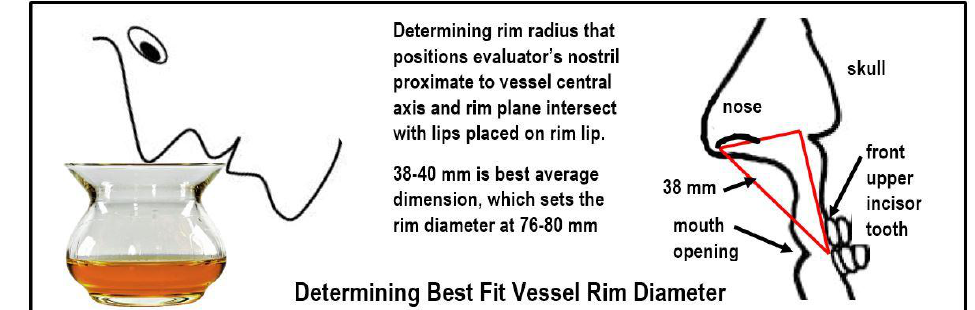
Figure 7. Establishing vessel rim size. Table 8. Vessel rim radius calculation. Rim plane radius of the engineered vessel is 39 mm.